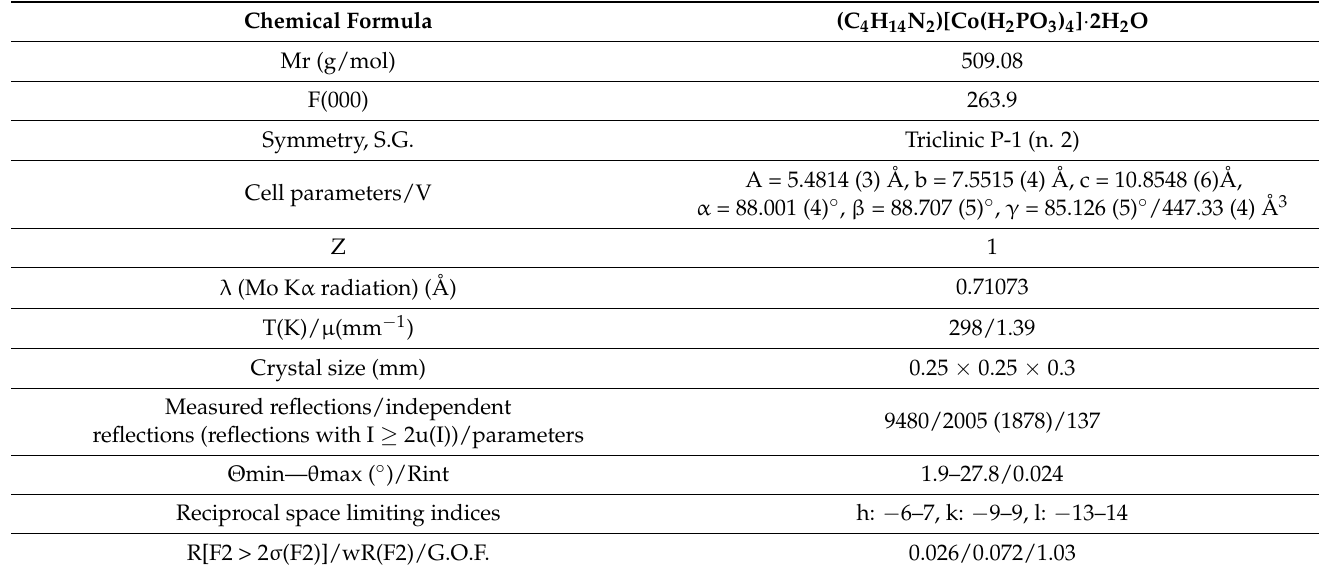
Table 1. Experimental X-ray data collection from (H 2 DAB)[Co(H 2 PO 3 ) 4 ] · 2H 2 O. Chemical